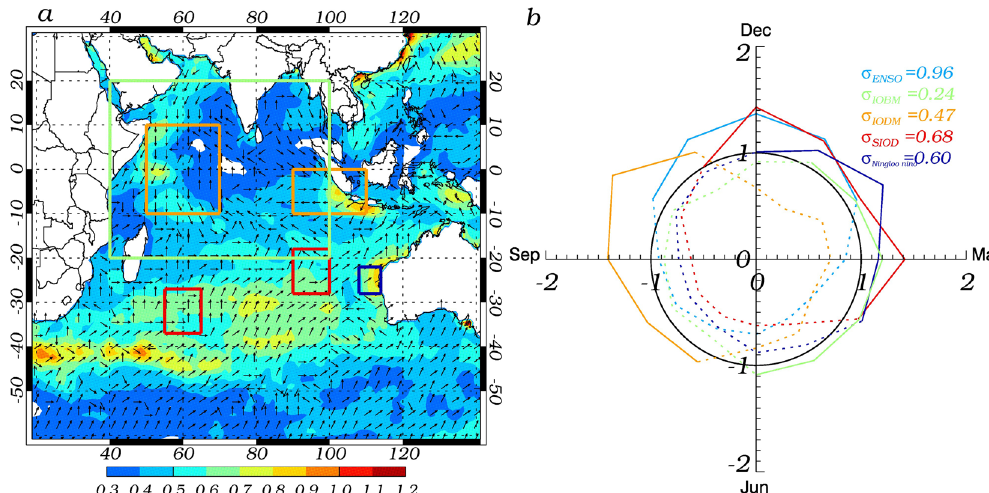
Figure 1. ( a ) The temporal and spatial distribution of maximum standard deviation of monthly mean SST ( ℃ ) in the Indian Ocean during 1982–2018 (the arrow indicates the month in which the maximum standard deviation occurs, increase clockwise, pointing north for December, pointing right for March). ( b ) The respective normalized monthly standard deviation of indexes, including those of El Niño and Southern Oscillation (ENSO) (light blue ), Indian Ocean Basin Mode (IOBM) (green), Indian Ocean Dipole Mode (IODM) (orange), Subtropical Indian Ocean Dipole (SIOD) (red) and Ningaloo Niño (dark blue). The solid (dashed) lines indicate the monthly standard deviation of indexes higher (lower) than one standard